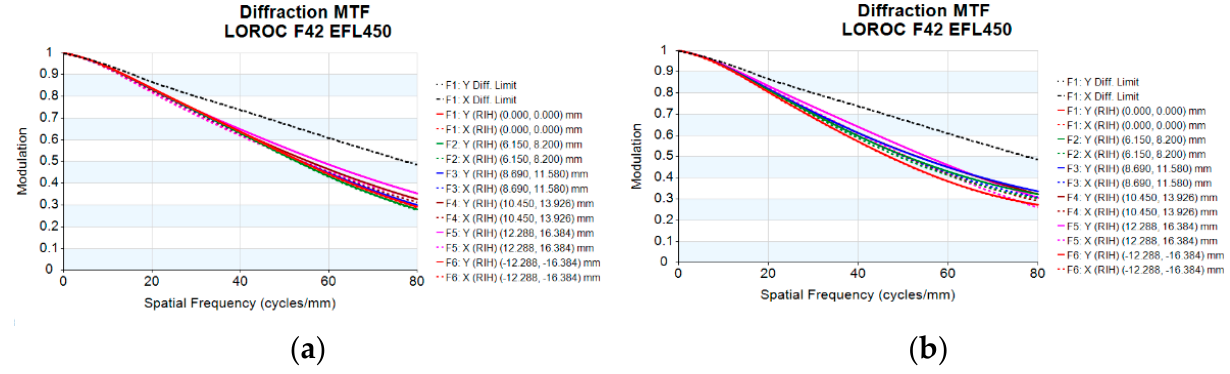
Figure 7. MTF curves of the optical system at different object distances after focusing on 1 km object distance: ( a ) 0.8 km object distance; ( b ) 1.3 km object distance.